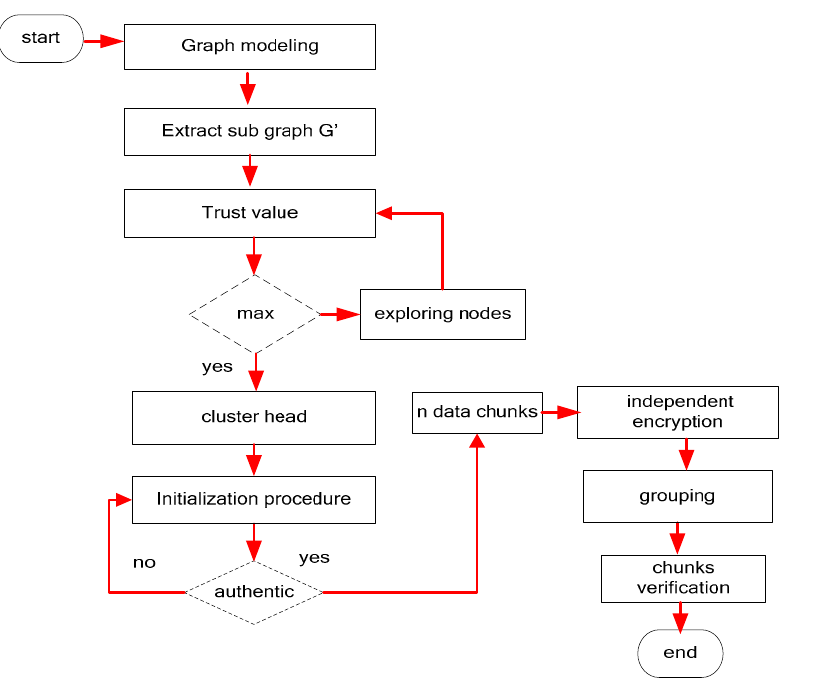
Figure 1. Components of the proposed algorithm.